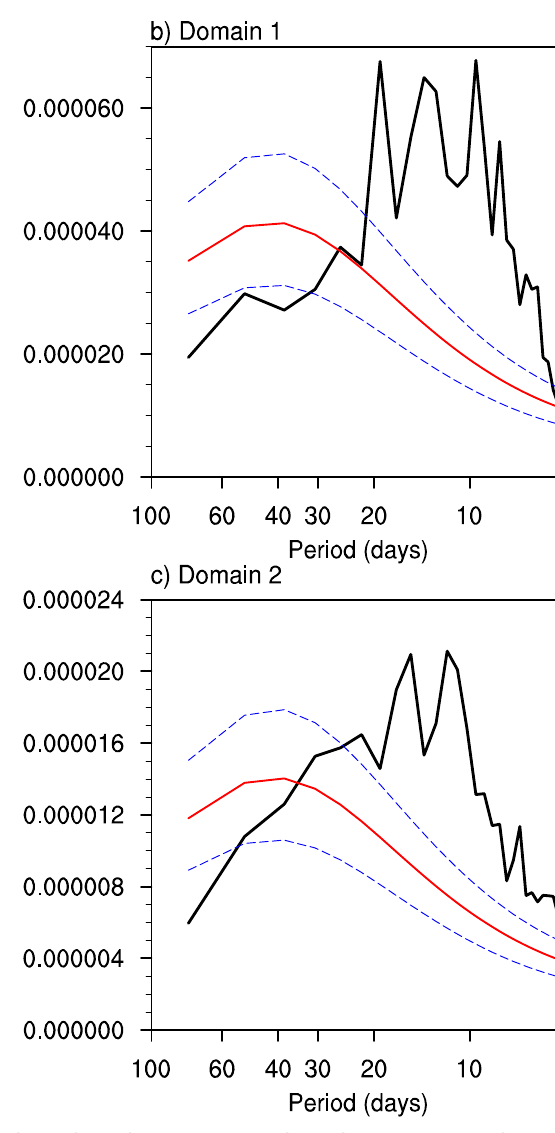
Fig. 1 Tropical storm days (TSDs) and their power spectra. a Climatological TSDs (per 100 days) during June – October, and the power spectra of 3-day running mean TSDs over the b domain 1 and c domain 2 shown in a